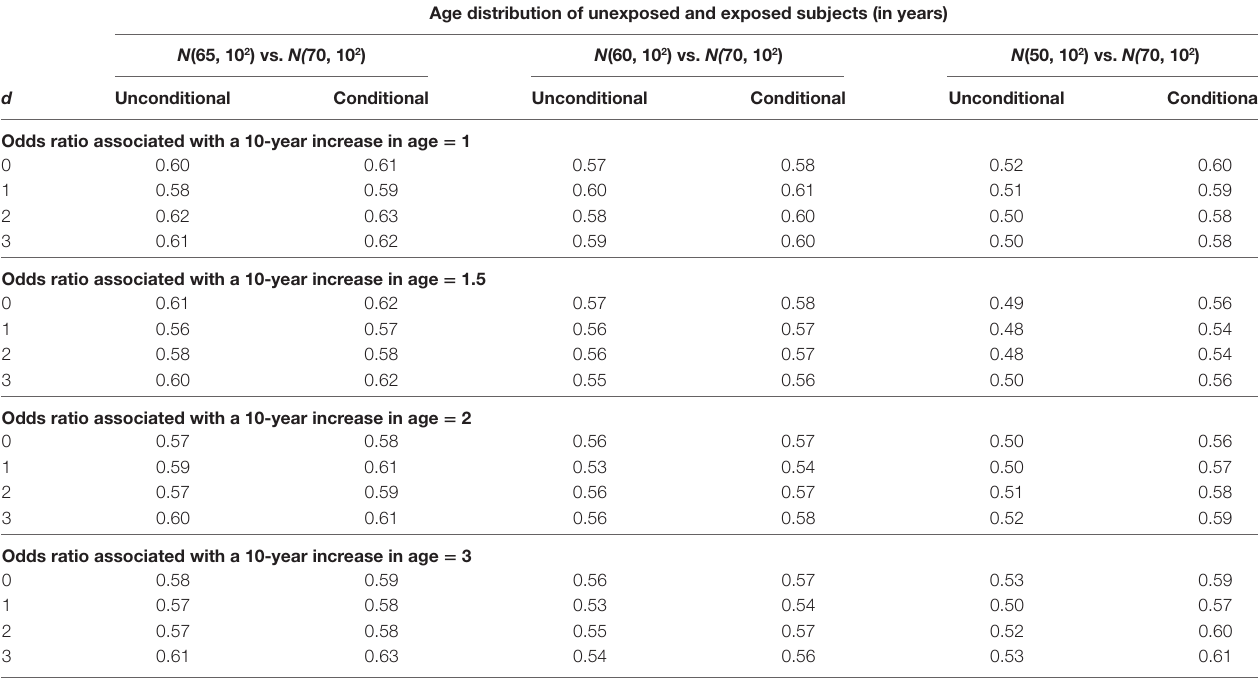
Table 4 | Widths of 95% confidence interval of unconditional and conditional logistic regression models under the null hypothesis.